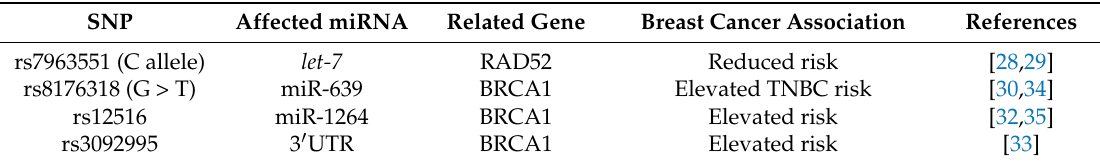
Table 1. miR-SNPs and DNA Damage Repair Genes Involved in Breast Cancer